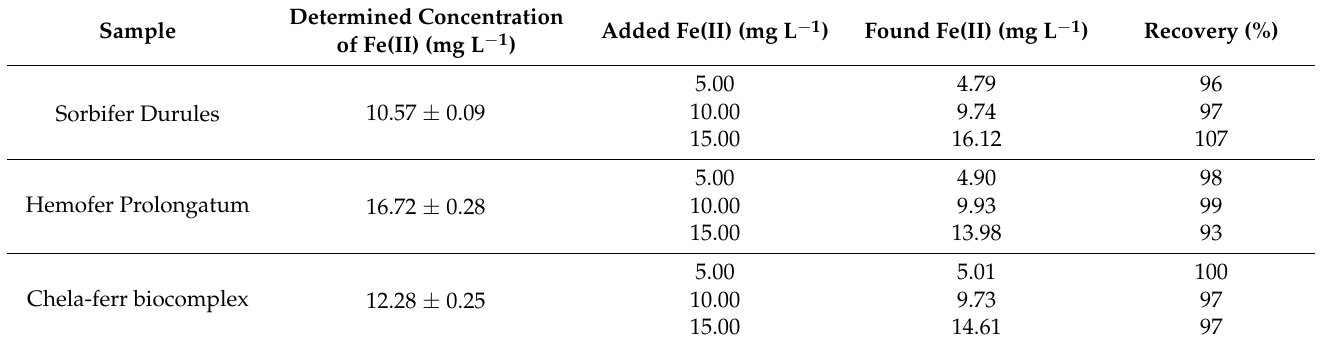
Table 2. Study of recovery. Results of determination of Fe(II) in pharmaceutical preparations. Results represent the average of at least three determinations ± S.D. Sample